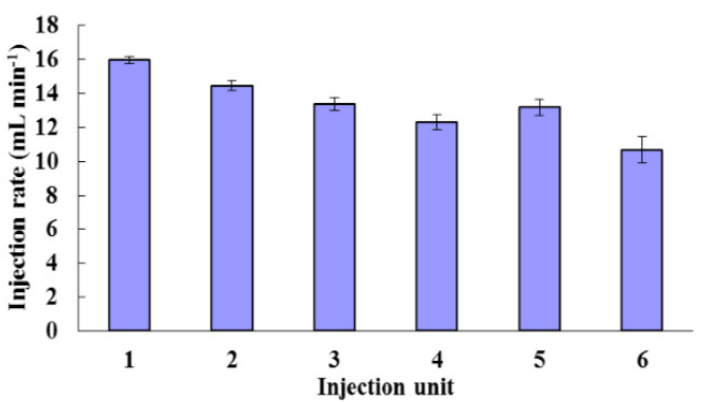
Figure 6. Injection rates of 6 RRVs within one boom section, when PWM signal was with pulse width 1000 μ s.